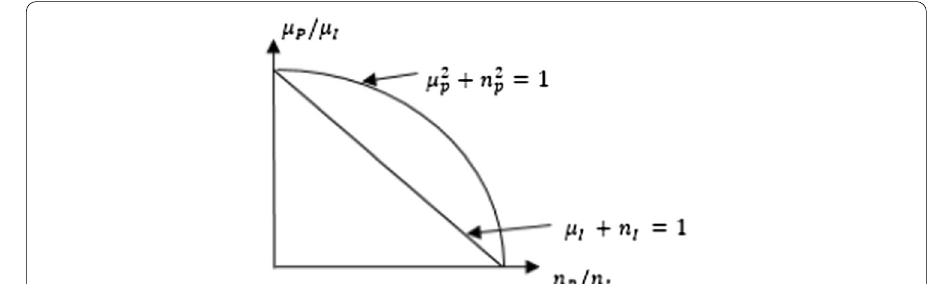
Fig. 1 Membership and non-membership degrees of IFS and